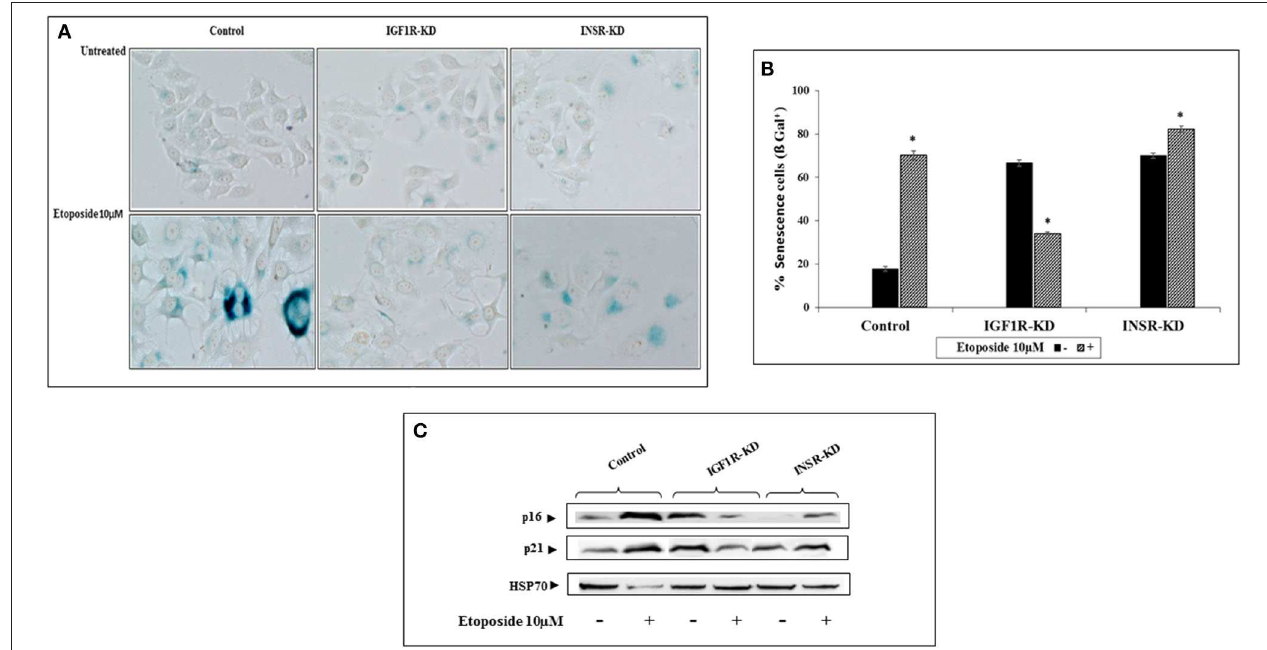
FIGURE 7 | Effect of INSR or IGF1R disruption (KD) on etoposide-induced senescence. (A) Senescence-associated beta-galactosidase (SA- β -gal) staining (blue/green) in MCF7 stable cells after treatment with etoposide (10 µ M) for 48h. (B) Percentage of SA- β -gal positive cells was counted in at least three random fields from quadruplicates samples. Graph represents means ± SEM ( n = 4). *Statistically significantly different from controls, p < 0.01. (C) Western blotting of p16 and p21 protein expression in the presence ( + ) or absence (–) of etoposide in MCF7 stable cells. Hsp70 was used as a loading control. Splicing has occurred in the blot figures and full scans of the entire original gels is presented in Supplementary Material . Squares denote bands shown in the final